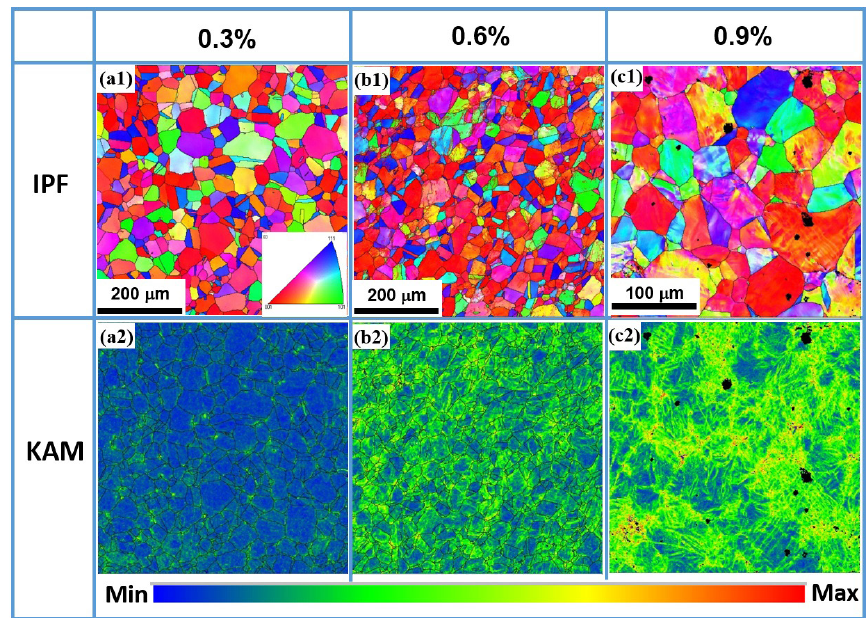
Figure 3. EBSD analysis on the fatigue samples at Δε